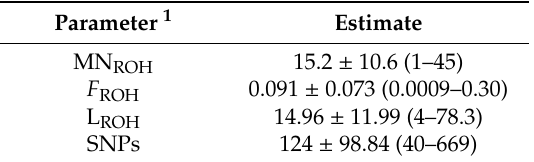
Table 2. Descriptive statistics for runs of homozygosity